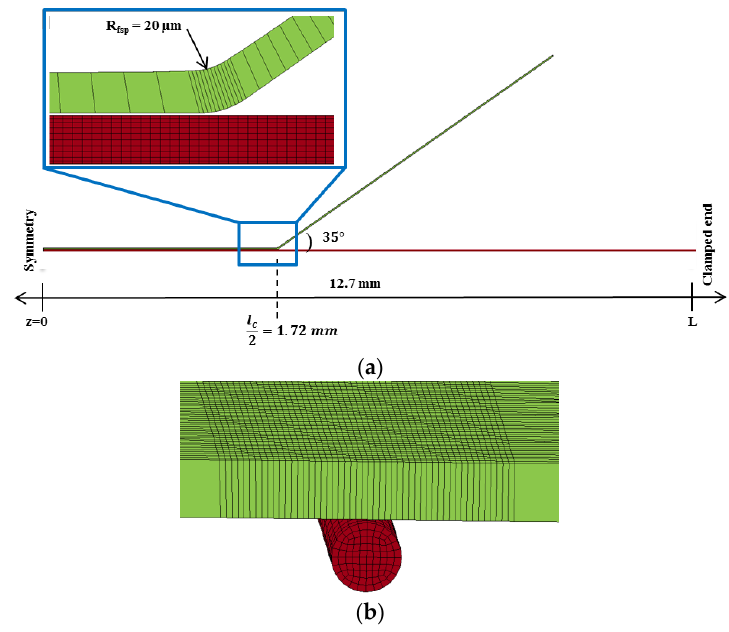
Figure 6. Half-symmetric 3D single-fiber model: ( a ) FSP impact at the mid-span; and ( b ) fiber cross-section.